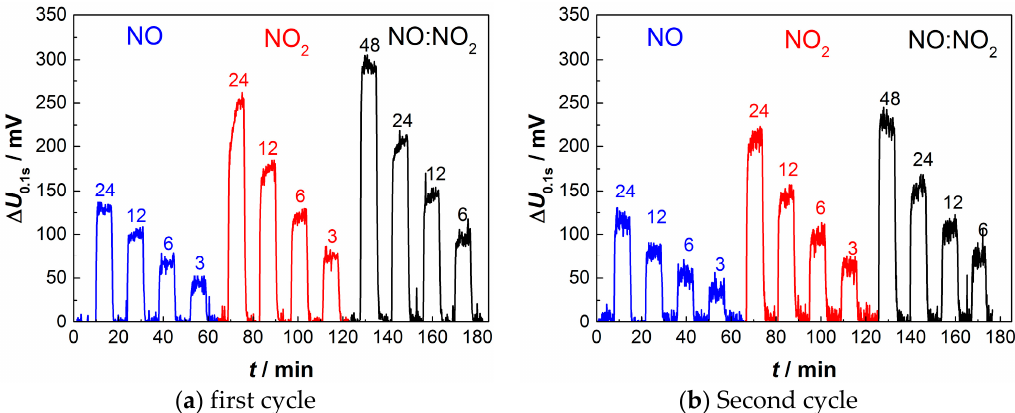
Figure 7. Sensor output voltage Δ U 0.1s at NO and NO 2 concentrations between 24 ppm and 3 ppm, and NO:NO 2 (1:1) mixtures between 48 ppm and 6 ppm, respectively, after alternating pulses during